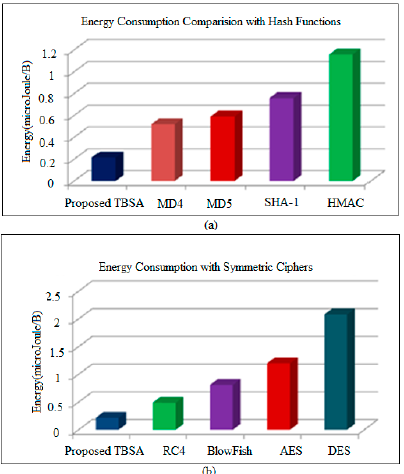
Figure 11. Energy consumption comparison of proposed TBSA ( a ) with Hash Functions; ( b ) with Symmetric Cipher.